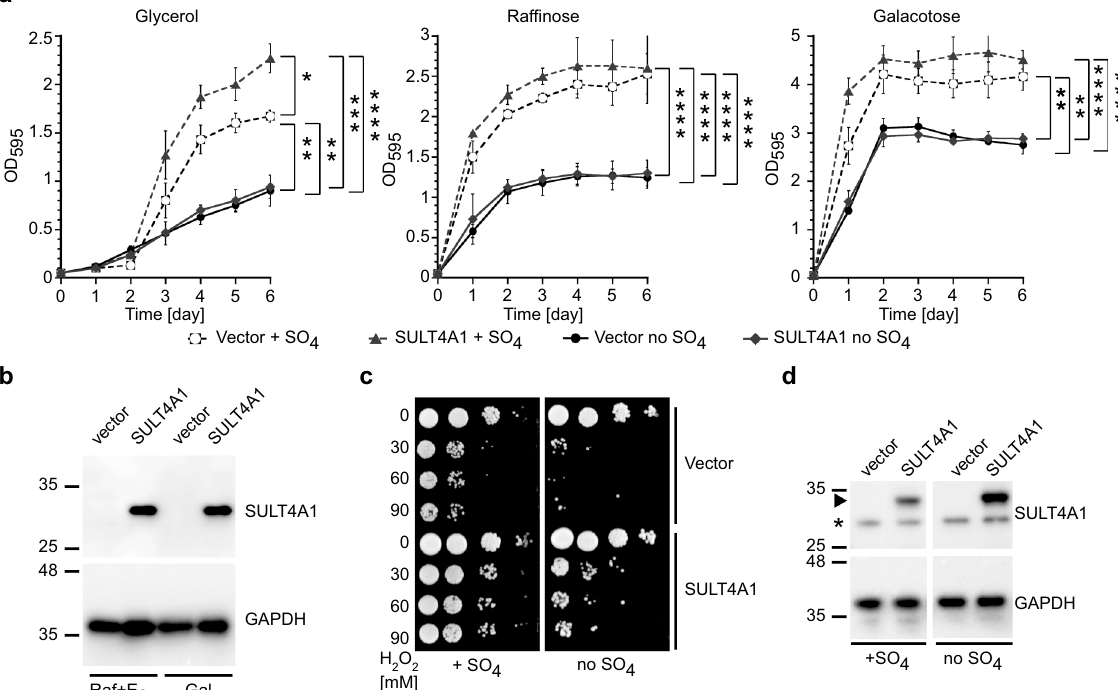
Figure 4. SULT4A1 protection to metabolically generated and H 2 O 2 induced oxidative toxicity is sulfate dependent. Yeast transformed with YCpGAL1 SULT4A1 •L (triangle and diamond) or vector control (open and closed circle) were cultured in media supplemented with ( a ) glycerol with 1 μg/ml E2; raffinose with 1 μg/ml E2 and galactose, with (dotted line) or without (solid line) additional ammonium sulfate (SO 4 ). Exponentially growing cultures were diluted to an OD 595 of 0.05 at day 0 and incubated at 30 °C. OD 595 was determined every day for 6 days. Shown is the mean and SD of three independent experiments. One way ANOVA followed by Tukey multiple comparison test using Prism; *P < 0.05, **P < 0.01, ***P < 0.001, ****P < 0.0001. ( b ) Yeast transformed with YCpGAL1 SULT4A1 •L (SULT4A1) or control (vector) were induced for 36 h in galactose or raffinose + 1 μg/ml E2 and total lysates were isolated from exponentially growing cultures. 20 μg of protein of each was resolved via SDS-PAGE and transferred to a PVDF membrane followed by immunostaining for SULT4A1 followed by stripping and immunostaining for the loading control GAPDH. Protein ladder with sizes in kDa. ( c ) Galactose-induced exponentially growing cultures, with or without additional ammonium sulfate, of yeast transformed with YCpGAL1 SULT4A1 •L (SULT4A1) or control (vector) were aliquoted and treated with 0, 30, 60 and 90 mM H 2 O 2 for 1 h at 30 °C, corrected to an OD 595 of 0.3, tenfold serial diluted and spotted on galactose plates with or without additional ammonium sulfate, incubated at 30 °C. ( d ) Yeast transformed with YCpGAL1 SULT4A1 •L (SULT4A1) or control (vector) were induced for 36 h in galactose with or without additional sulfate-salt and total lysates were isolated from exponentially growing cultures. 20 μg of protein of each were resolved via SDS-PAGE and transferred to a PVDF membrane followed by immunostaining for SULT4A1 followed by stripping and immunostaining for the loading control GAPDH. Arrowhead points at SULT4A1, *non-specific staining of anti-SULT4A1 antibody. Protein ladder with sizes in